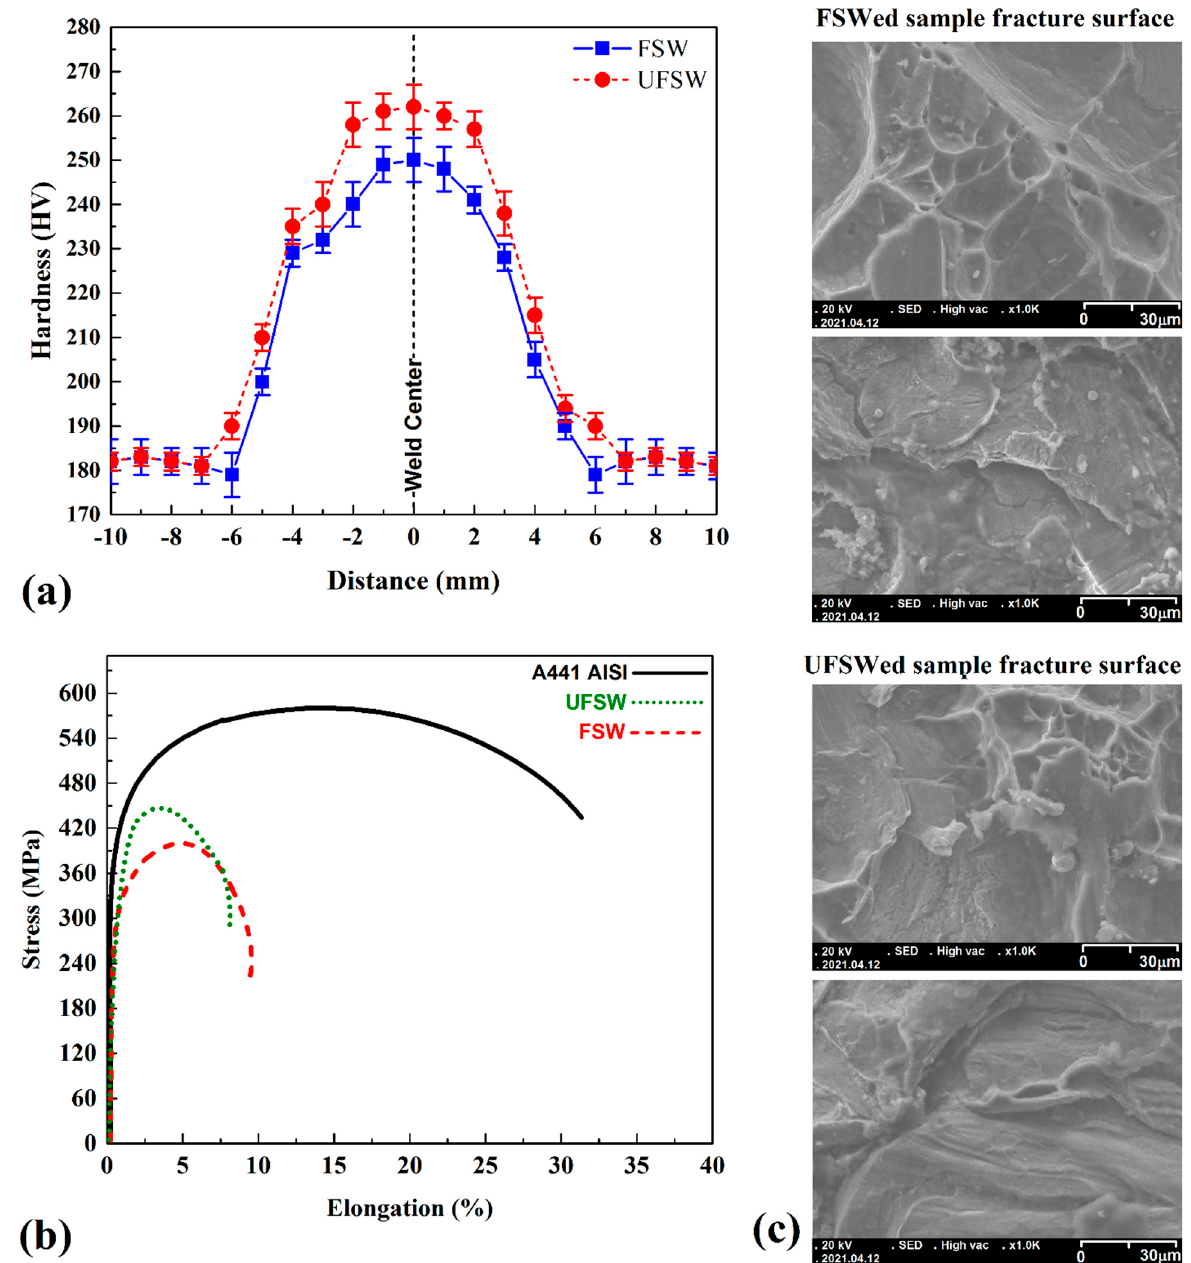
Figure 8. ( a ) Hardness of joint line at regular and underwater FSW cases. ( b ) Stress-strain graph of welded samples and ( c ) fracture surface of FSWed and UFSWed tensile samples.